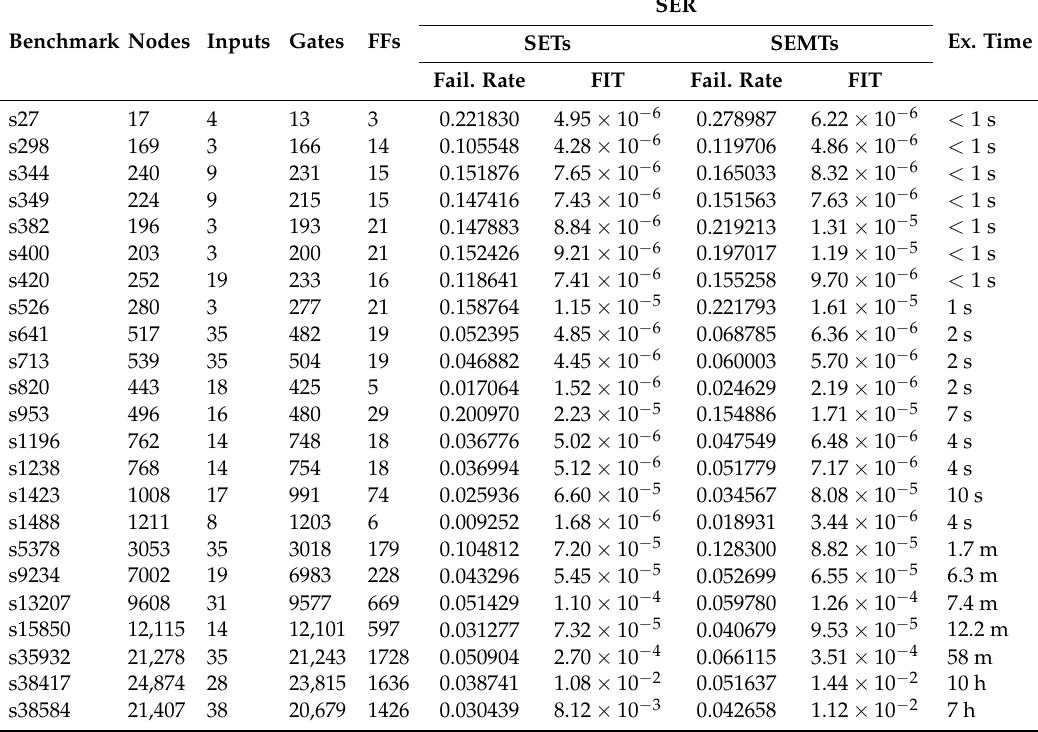
Table 1. SER evaluation results obtained from the proposed tool for ISCAS’ 89 benchmarks. The number of nodes, primary inputs, gates and D-type FFs indicate the benchmarks’ complexity, SETs denotes the consideration of single transient faults, SEMTs denotes the consideration of multiple transient faults, Fail. Rate is the SER probability, FIT is the SER in terms of FIT, whereas Ex. Time denotes the average execution time of the